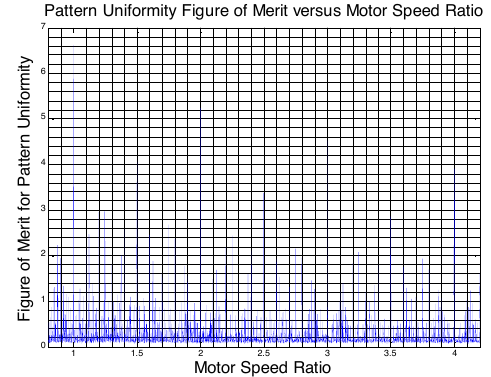
Figure 3: Figure of Merit (FOM) of the scan uniformity versus the motor speed ratio.